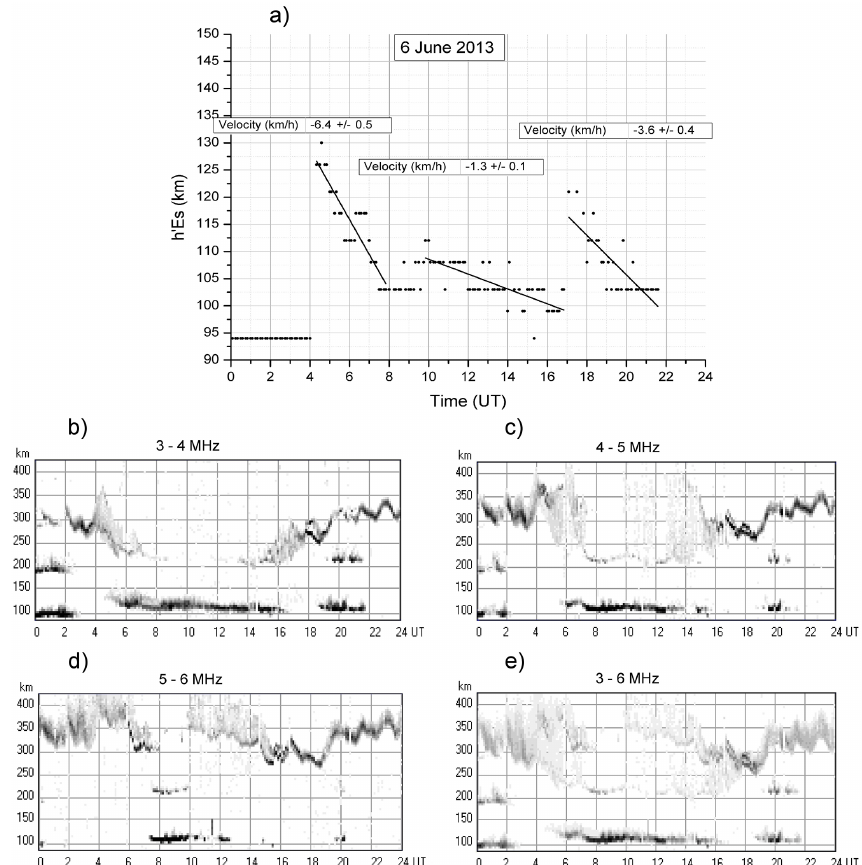
Figure 6. (a) h’Es values manually validated for the 6 June 2013, with the corresponding linear fits, and the HTI plots generated for the same day for different frequency ranges: (b) 3–4MHz, (c) 4–5MHz, (d) 5–6MHz, and (e)